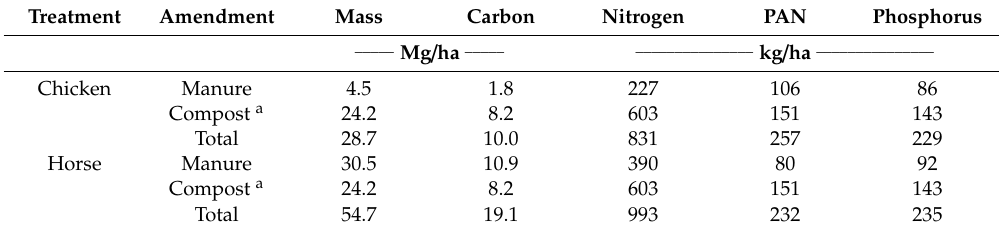
Table 2. Mass and nutrient inputs (expressed as dry weight) for the two treatments used in the current study, where PAN = estimated plant-available